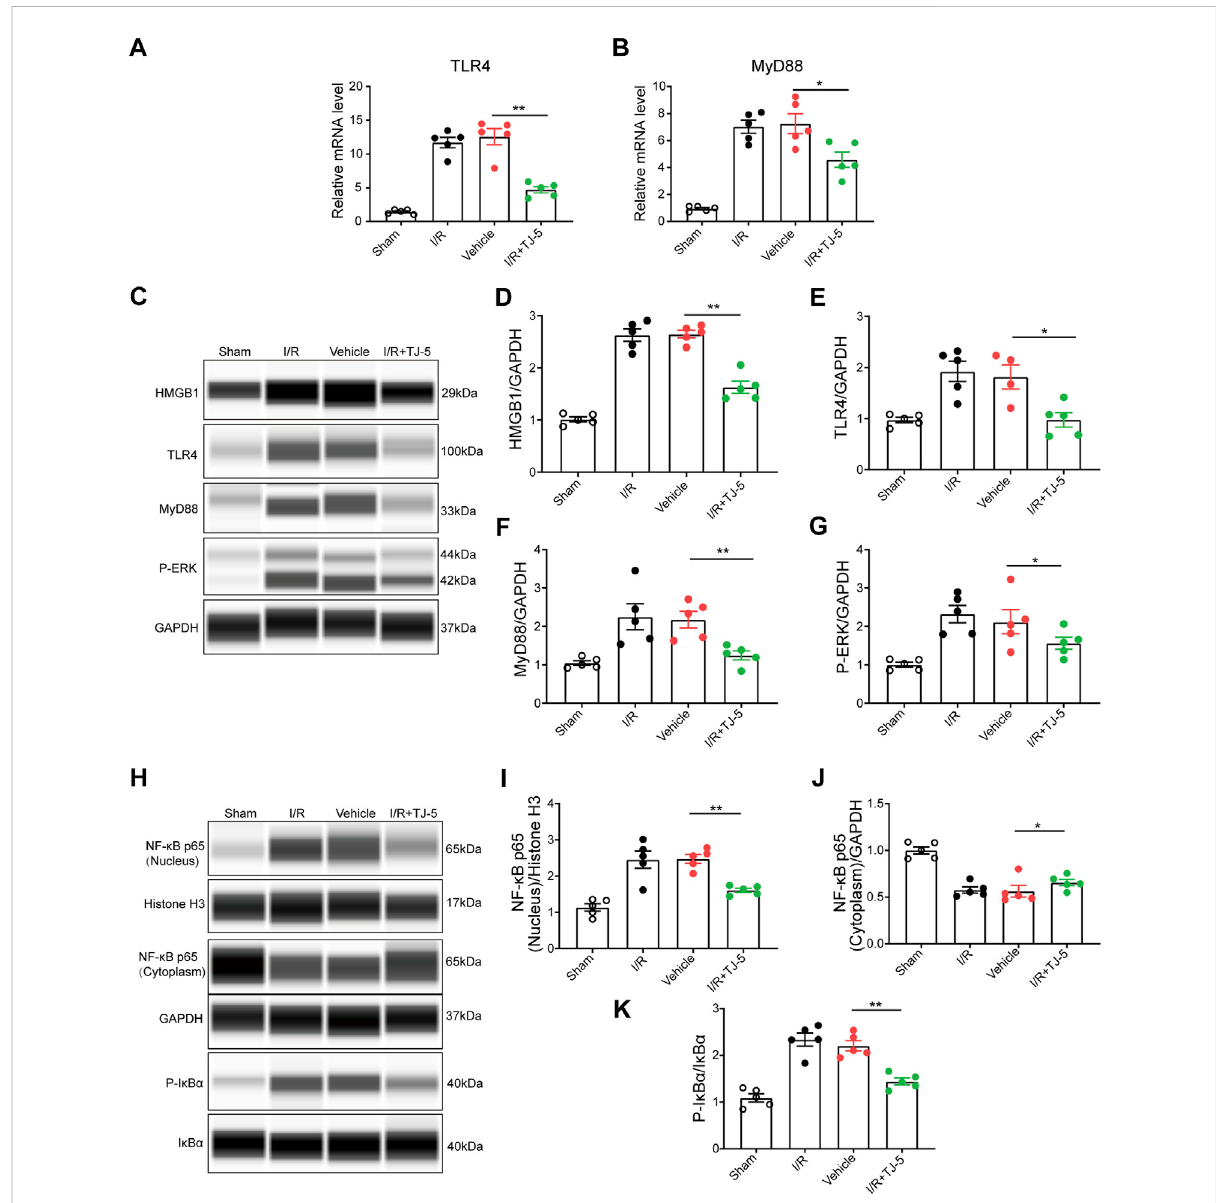
FIGURE 4 TJ-5 downregulates the MyD88/NF- κ B and ERK signaling pathway in CIRI mice. (A,B) The mRNA levels of TLR4 and MyD88 in the brain were detected. (C – G) HMGB1, TLR4, MyD88, and P-ERK protein levels in the brain were assessed and analyzed. (H – K) Cytoplasmic and nuclear proteins were extracted from the brain to detect the NF- κ B p65 protein levels and analyze phosphorylation of I κ B α and NF- κ B p65 nuclear translocation. All the experiments were repeated three times. Values are mean ± SEM. (* p < 0.05, ** p <